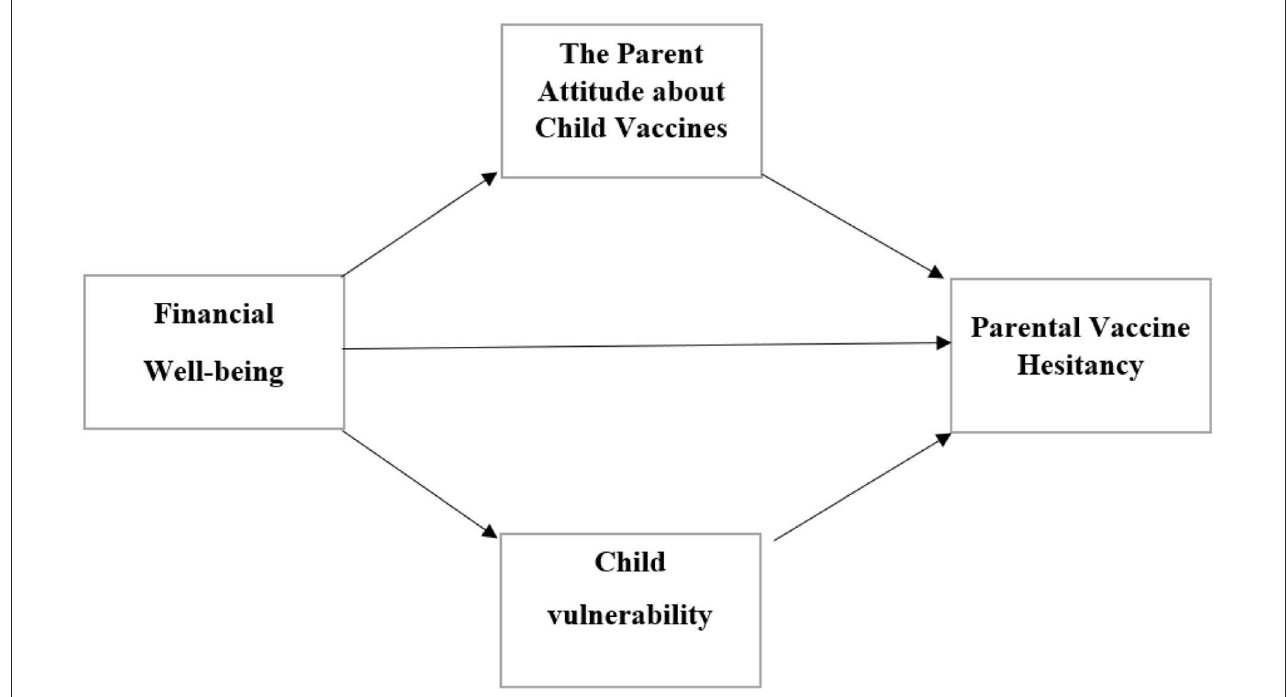
FIGURE1 The proposed mediating